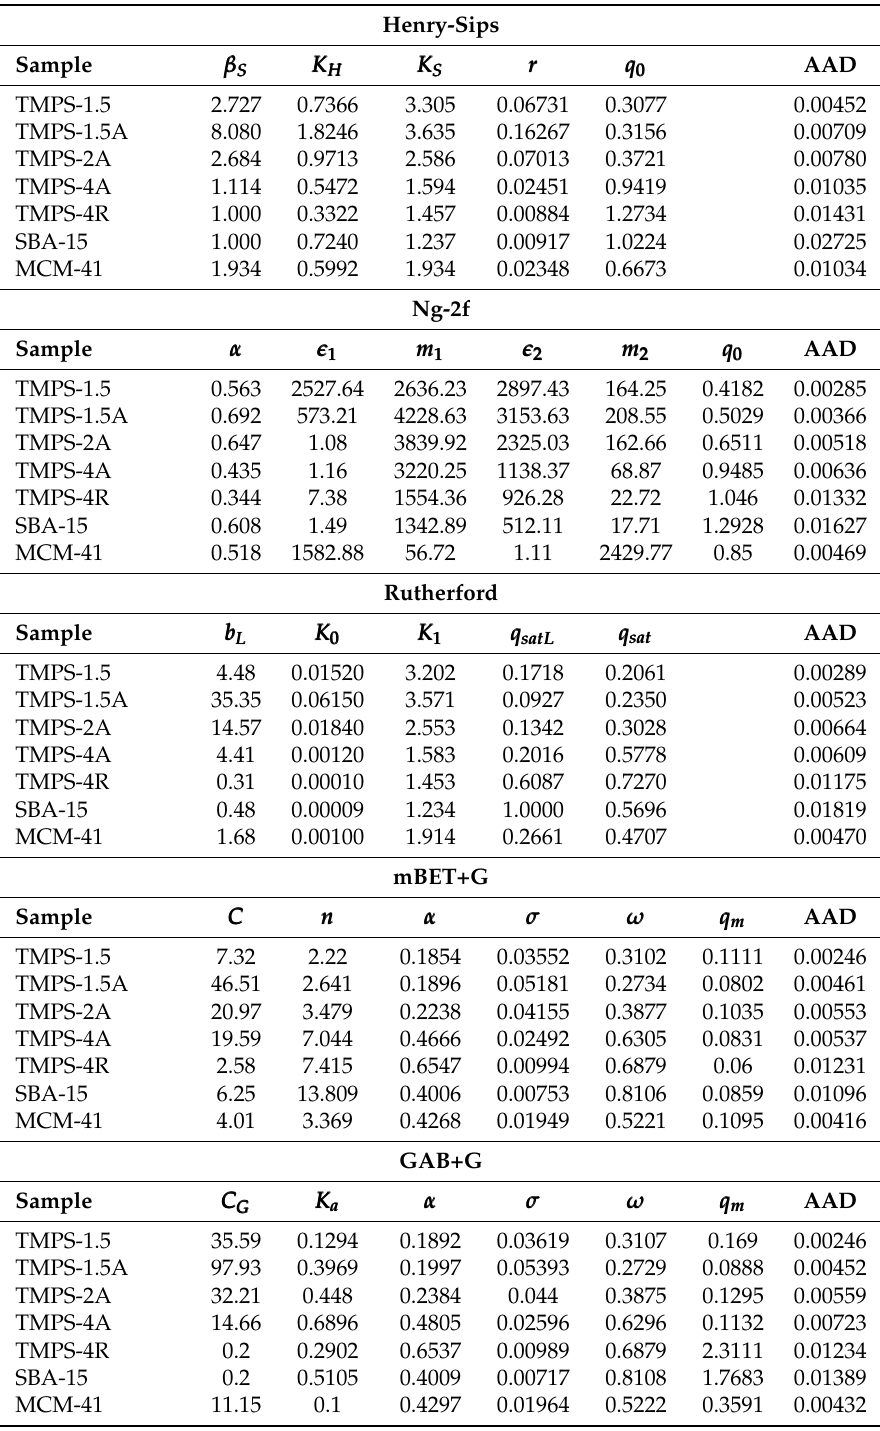
Table 4. Adsorption models’ fitting parameters and constants for all samples at 25 ◦ C (20 ◦ C for SBA-15 and MCM-41) with average absolute deviation (AAD) of the fit of the experimental